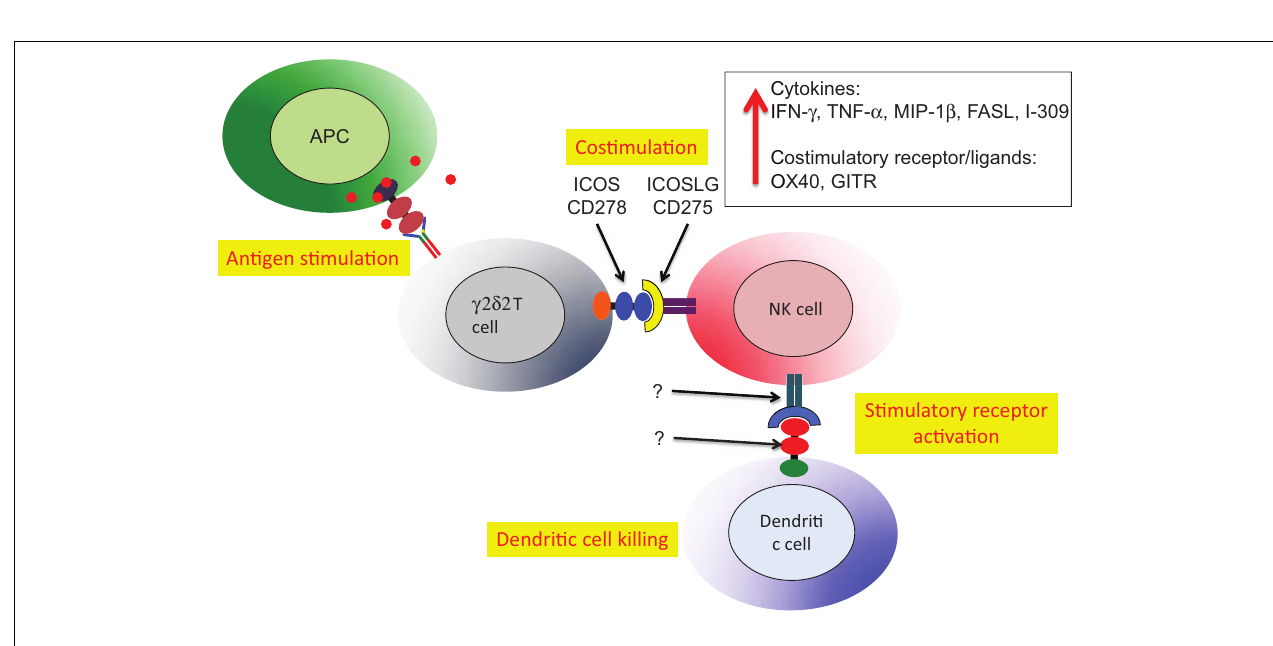
receptor(s) on NK and recognition molecules on dendritic cells have not been identified. Similar to the example in Figure 4 , HIV-mediated